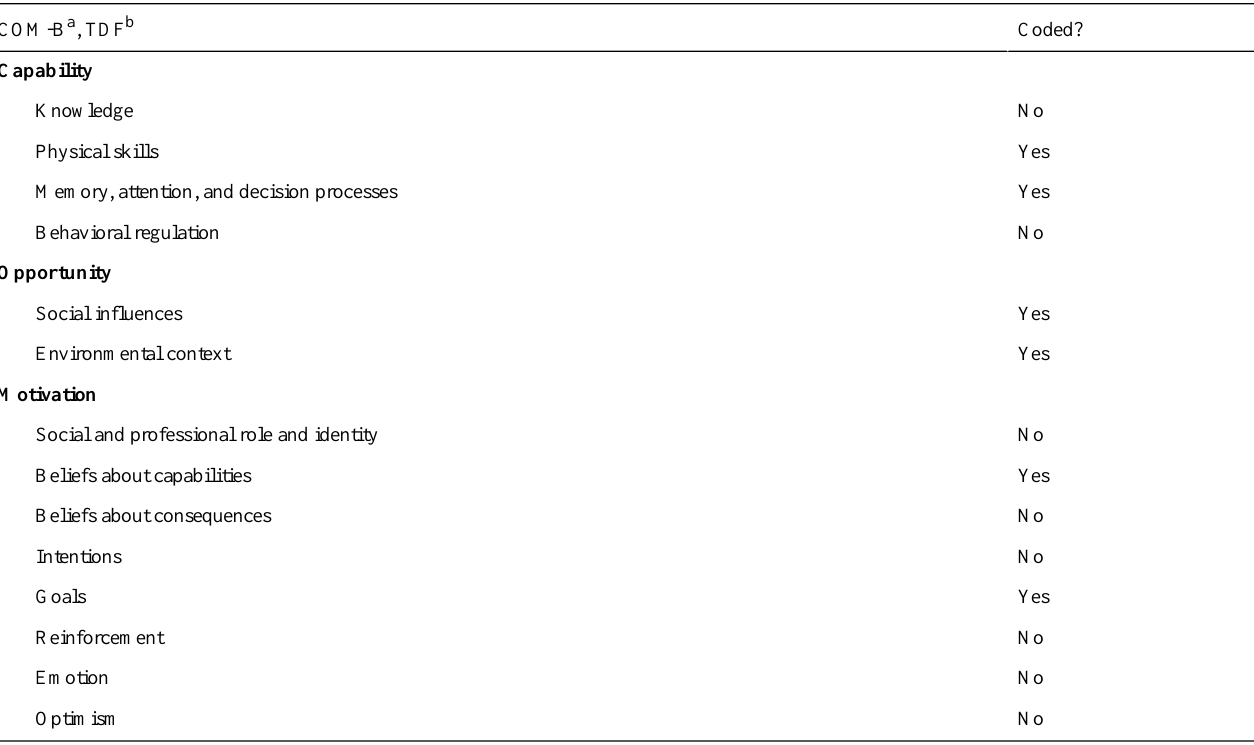
Table 2. Theoretical domains that were coded against the theoretical domains framework and those that were not.